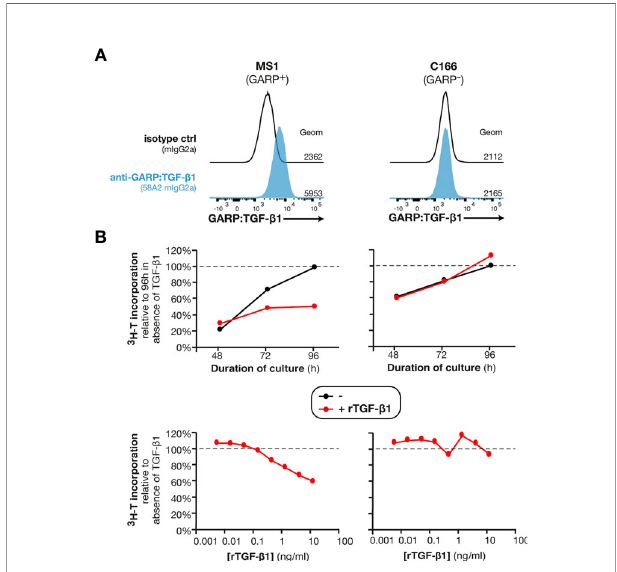
FIGURE 5 | Recombinant TGF- b 1 exerts a cytostatic effect on GARP + endothelial cells in vitro . (A) Flow cytometry analyses of MS1 and C166 murine endothelial cell lines stained with anti-GARP:TGF- b 1 antibody (clone 58A2) or isotype control. Histograms are gated on live single cells. Geom, geometric mean fl uorescence intensity. (B) C166 and MS1 cells were seeded in presence or absence of rTGF- b 1 (top: 1 ng/ml; bottom: indicated concentrations) and cultivated during 48, 72 or 96 h (top) or 96 h (bottom). Tritiated thymidine ( 3 H-T) was added during the last 24 h of culture, and cells were collected to measure 3 H-T incorporation as a read-out of proliferation. Data points represent means of triplicate wells. Results are representative of three independent